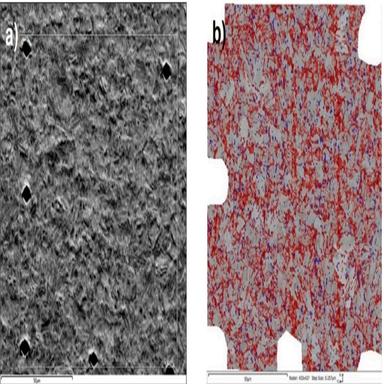
a) SEM-FSD Image of EBSD analysis area. b) EBSD analysis solved with "Re-classify" tool in AztecCrystal. In this image, different phases and microstructures can be pointed out: austenite (in blue: 4.41%), ferrite (in grey: 61.25%), and martensite (in red:34.34%). The step size is 0.257 µm. The rolling direction is across the vertical axis. White areas are related to the micro indentation marks and are excluded from the analysis.